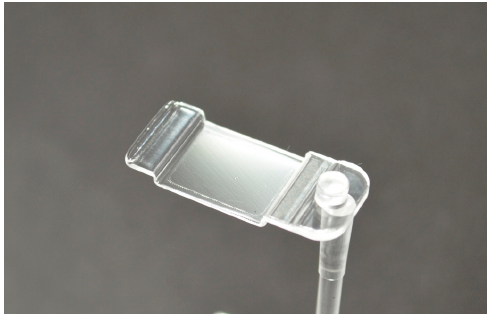
Figure 9. Injection compression molded MLA before the sprue is removed.